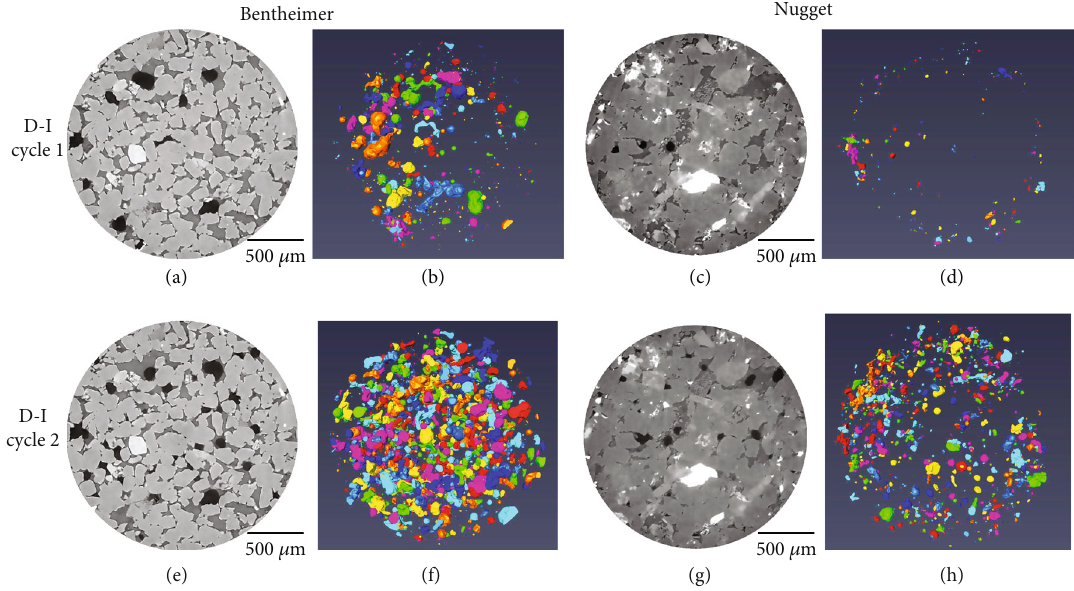
Figure 2: D-I cycle 1: (a) Bentheimer 2D cross-section, (b) Bentheimer scCO 3D volume; D-I cycle 2: (e) Bentheimer 2D cross-section, (f) Bentheimer scCO scCO 3D volume. The di ff erent colors represent separate scCO 2